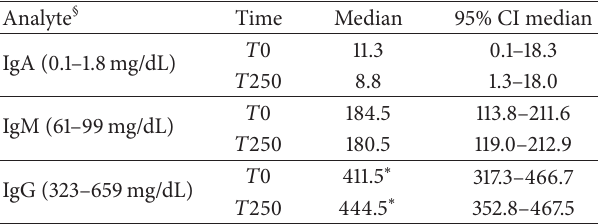
Table 2: Immunoglobulin concentration in Group 2 (10 dogs). Analyte §